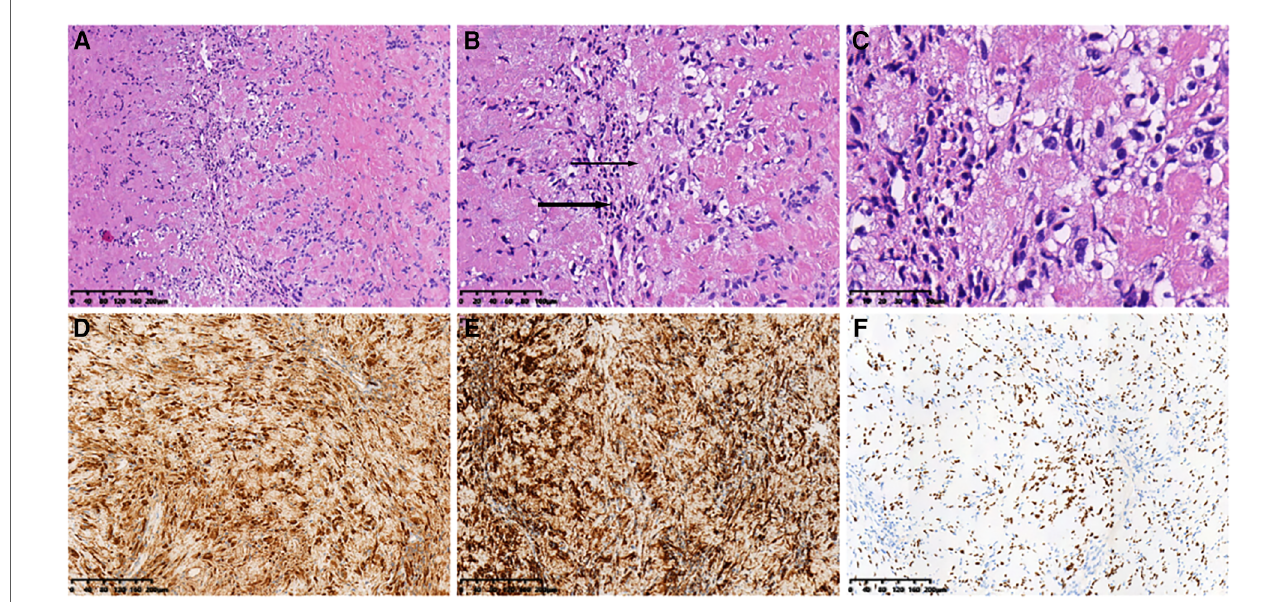
FIGURE 5 Histopathological features. ( A ) (HE ×10) Spindle tumor cells in bundles and the vortex arrangement. ( B ) (HE ×20) Alternating compact Antoni A (thick arrow) and loose Antoni B (thin Arrow) areas). ( C ) (HE ×40) Grid-like nuclear structure revealing Verocay bodies. Immunohistochemical analysis revealing positive staining for ( D ) S-100 (×10), ( E ) SOX10 (×10), and ( F ) Vimentin (×10) in most cells. HE, hematoxylin and eosin.